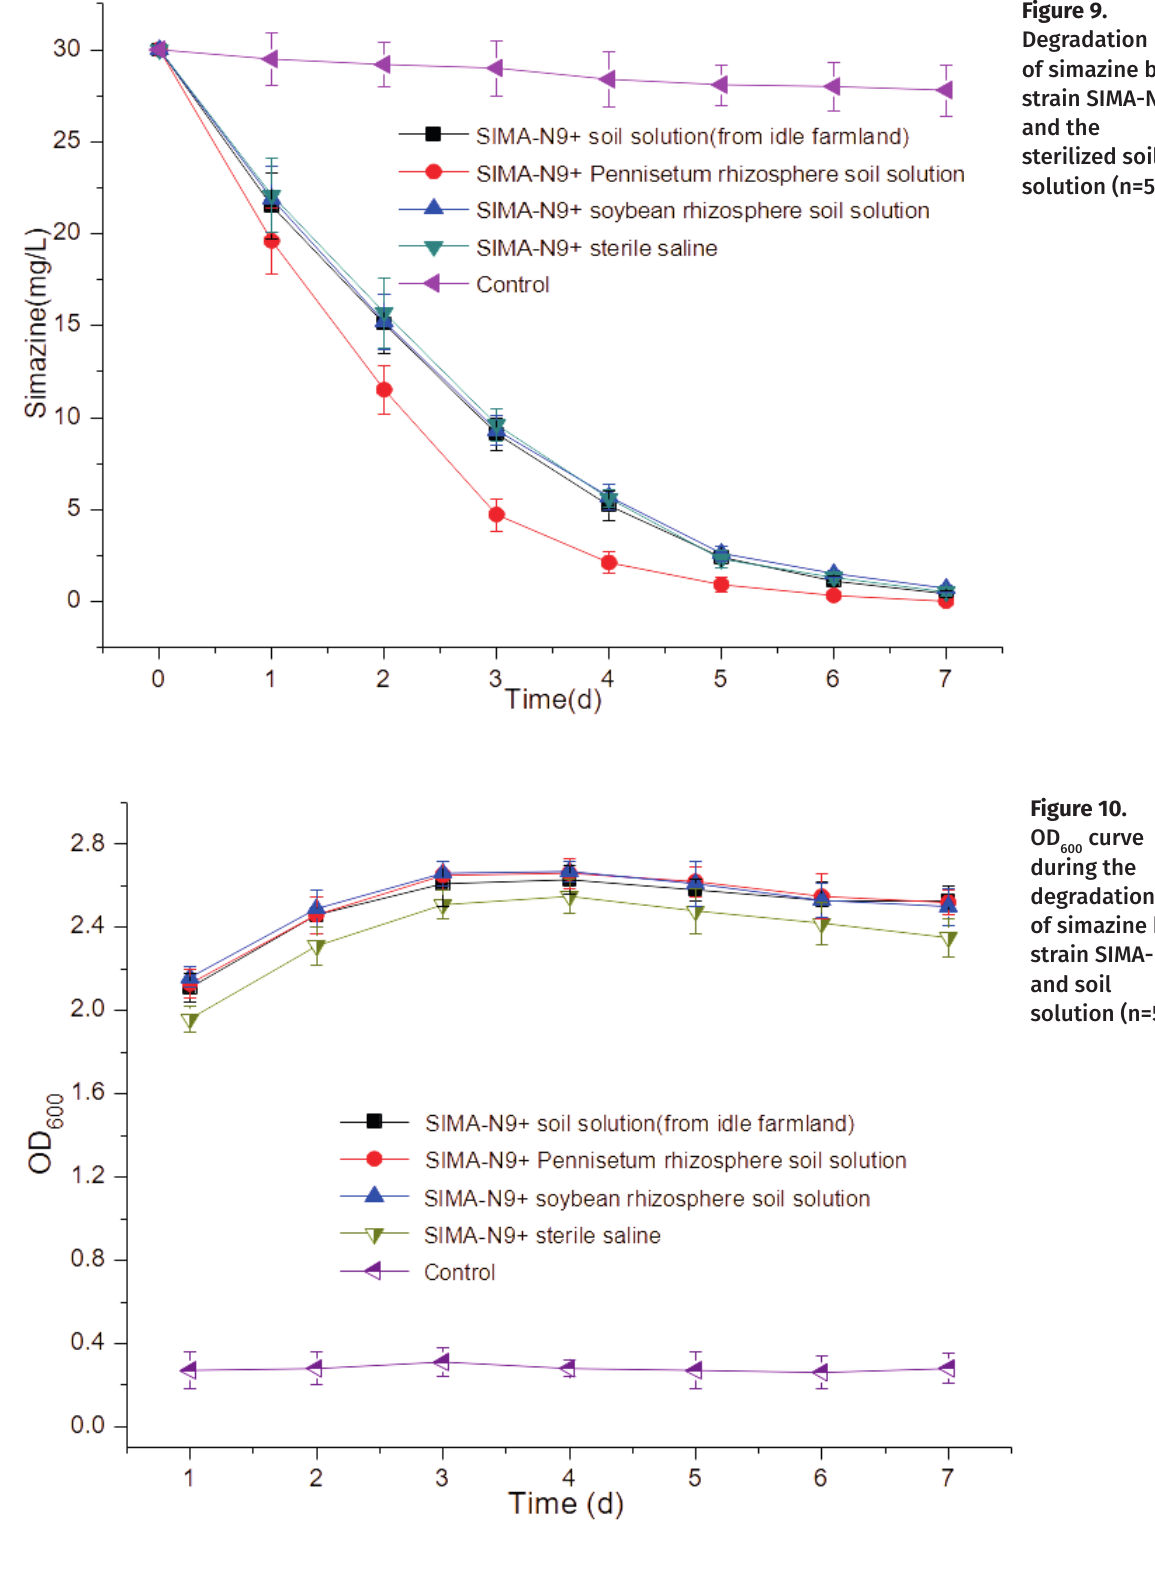
Figure 9. Degradation of simazine by strain SIMA-N9 and th e sterilized soil solution (n=5).